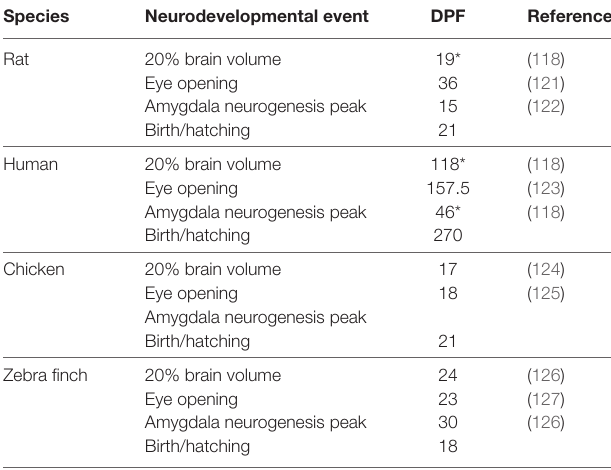
TABLe 2 | Data are presented for 20% brain volume, eye opening, amygdala neurogenesis peak, and the date of birth or hatching. Species Neurodevelopmental event